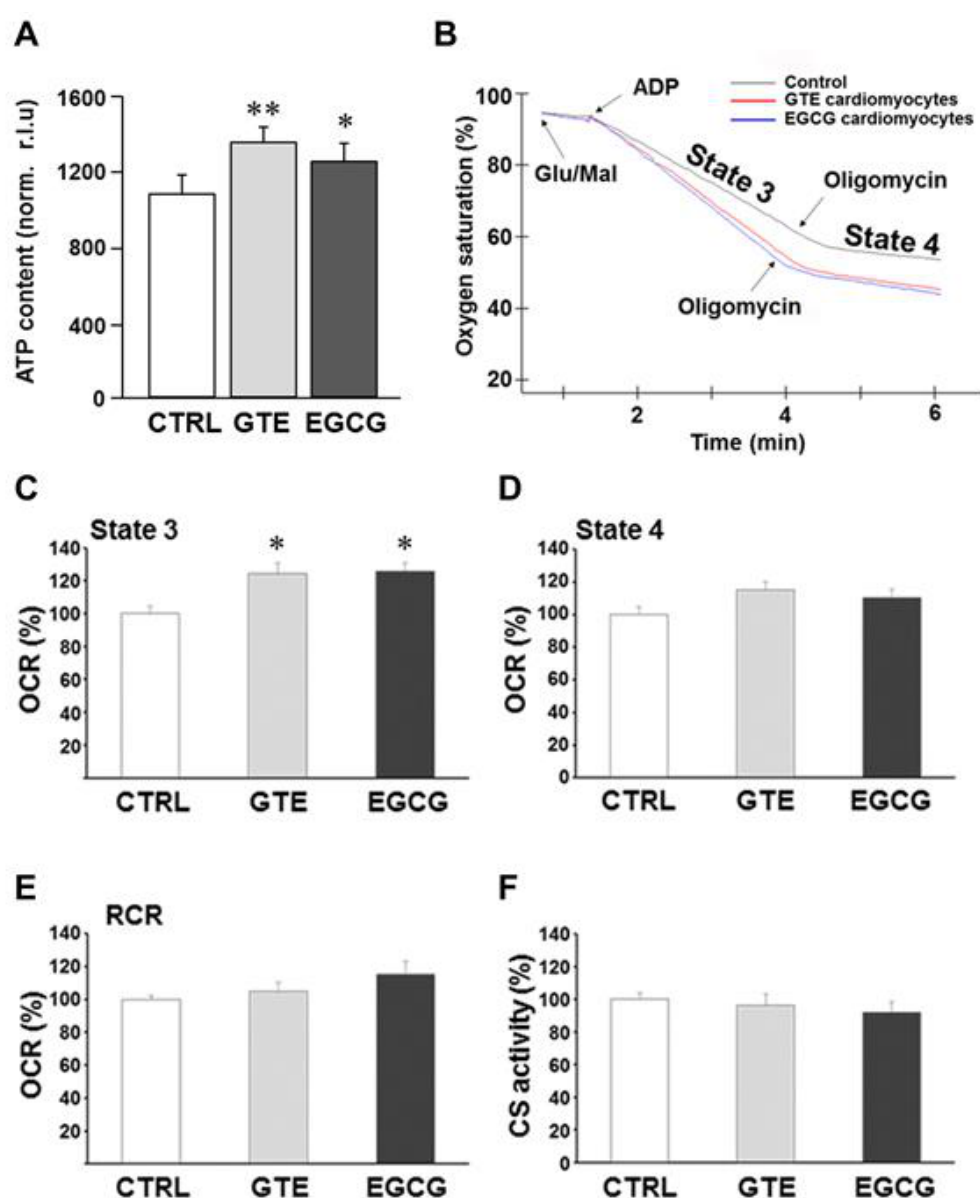
Figure 1. E ff ects of GTE and EGCG administration on rat cardiomyocyte ATP content and mitochondrial respiration. ( A ) ATP content of cardiomyocytes isolated from left ventricle (LV) myocardium of CTRL ( n = 5), GTE- ( n = 5) and EGCG-supplemented ( n = 5) rats, expressed as relative light units (RLUs) normalized to the protein content. ( B ) Typical complex I-driven oxygen consumption traces of permeabilized cardiomyocytes under di ff erent respiratory conditions. Respiration rates under state 3 ( C ) and state 4 ( D ) conditions expressed as percent of controls. ( E ) Respiratory control ratios (RCRs) (state 3 / state 4 respiration rate ratio) were reported as percent of controls. State 3 and state 4 respiration rates of controls were 189.19 ± 10.37 and 41.38 ± 3.02 nmol / min / 10 6 cells, respectively, and RCR was 4.59 ± 0.14. ( F ) The citrate synthase activity of GTE and EGCG rat cardiomyocytes was reported as percent of controls (7.68 ± 0.30 µ mol / min / 10 6 cells). Histograms show the mean ± SEM. * p < 0.05 and ** p < 0.01 indicate the statistical significance of data compared to controls. CTRL = Control; GTE = green tea catechin extract; EGCG = epigallocatechin-3- gallate.